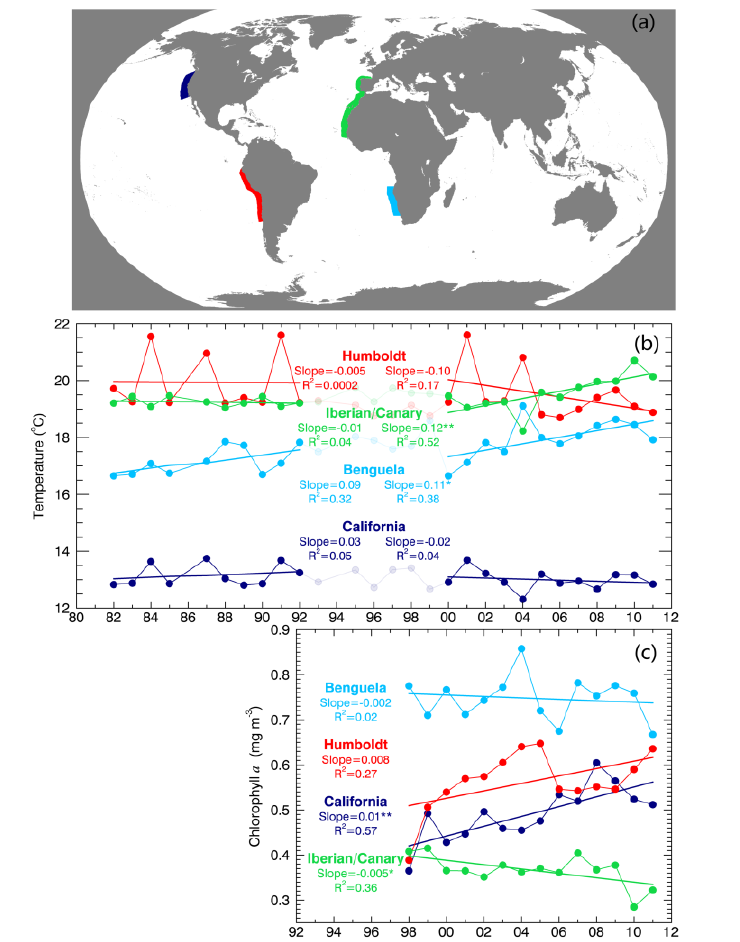
Figure 4. ( a ) Global map showing upwelling regions and ( b ) year versus annual sea surface temperature (based on satellite data) in upwelling regions (color coded) of the Benguela, Humboldt and California currents. An upward trend suggests slowing upwelling, no trend suggests steady upwelling and a downward trend suggests increased upwelling; and ( c ) SeaWiFS and MODIS annual surface chlorophyll concentration